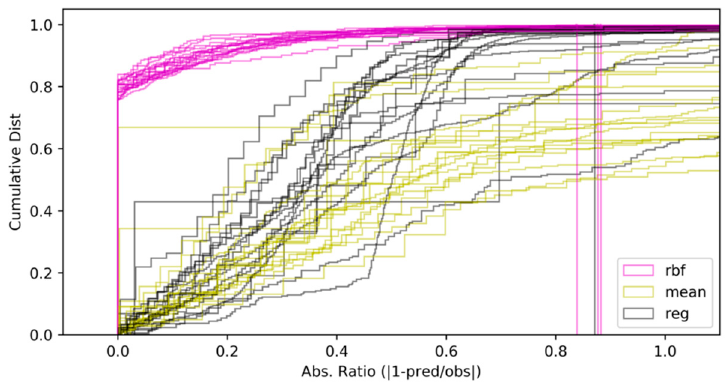
Figure A3. Assessment of three different approaches (radial basis function (RBF), mean value, and regression) for generating AOD estimates for missing pixels. The x -axis shows the error function evaluated for each approach, where pred is the predicted AOD for a missing pixel and obs is the observed AOD in that pixel. The radial basis function (RBF) performs best overall for the thirteen plumes evaluated, with typically ~80% of the refilled pixels evaluated in each plume having an error near zero.